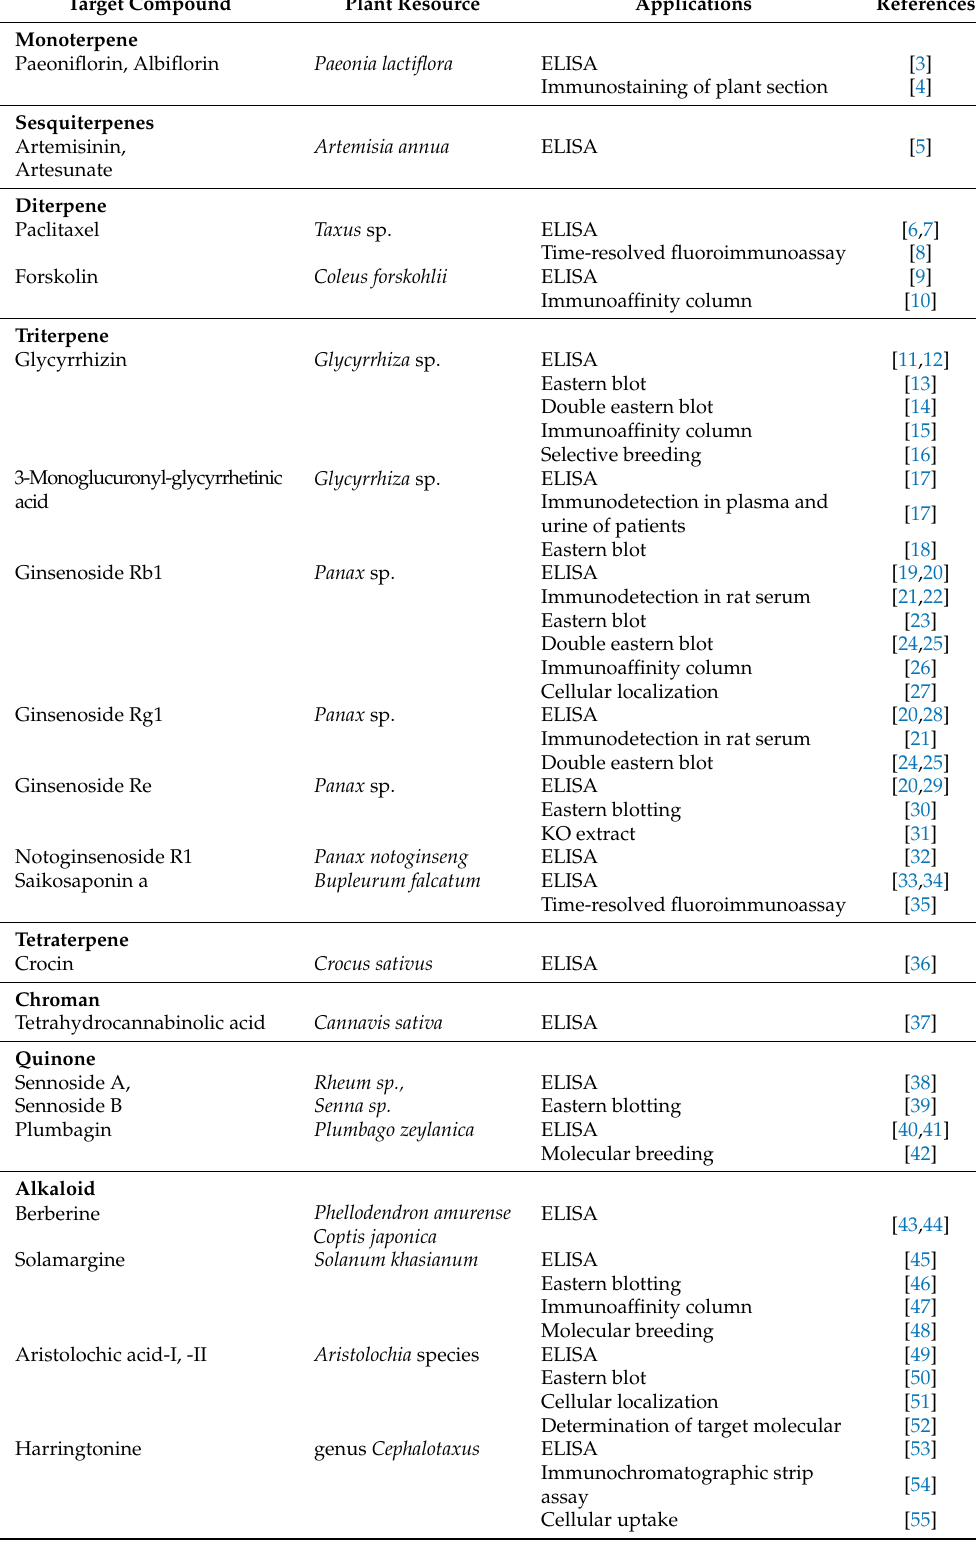
Table 1. Example of applications using MAbs against natural